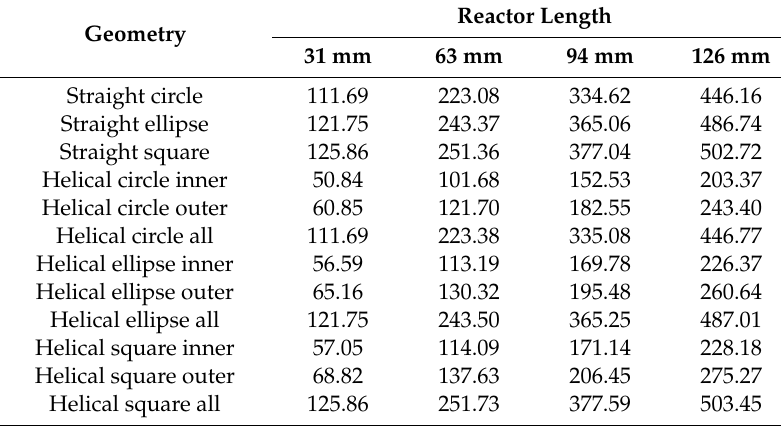
Table 3. Catalyst area (in cm 2 ) for various coating